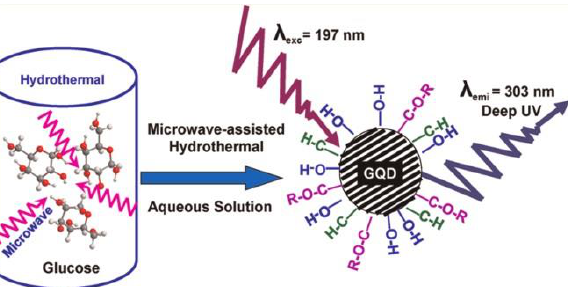
Figure 5. Self- passivation layer formed by surface states between π* band and π level . Reprinted Figure 5. Self-passivation layer formed by surface states between π * band and π level. Reprinted with permission from [43]. Copyright 2012, American Chemical Society. with permission from [43]. Copyright 2012, American Chemical